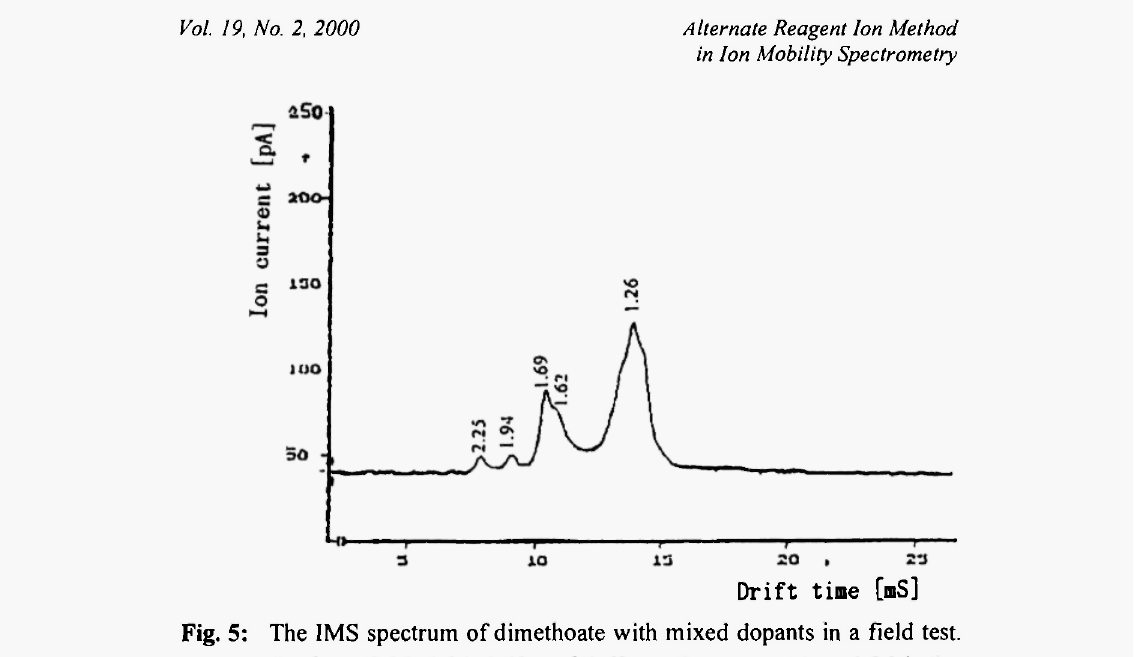
Fig. 5: The IMS spectrum of dimethoate with mixed dopants in a field test. (Peaks at 2.25, 1.94, 1.69, and 1.62 are the reactant ions 1.26 is the dimer ion of dimethoate.)